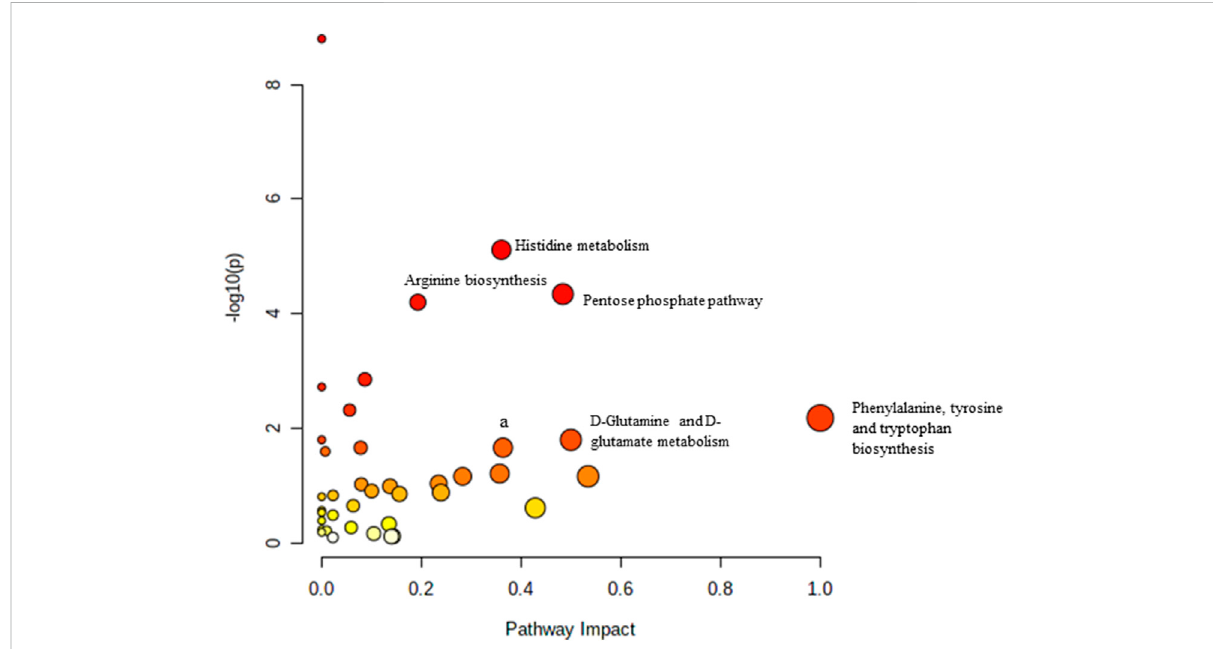
FIGURE 4 Biochemical pathway analysis of metabolites pro fi led for AC vs. OC. a: Fructose and mannose